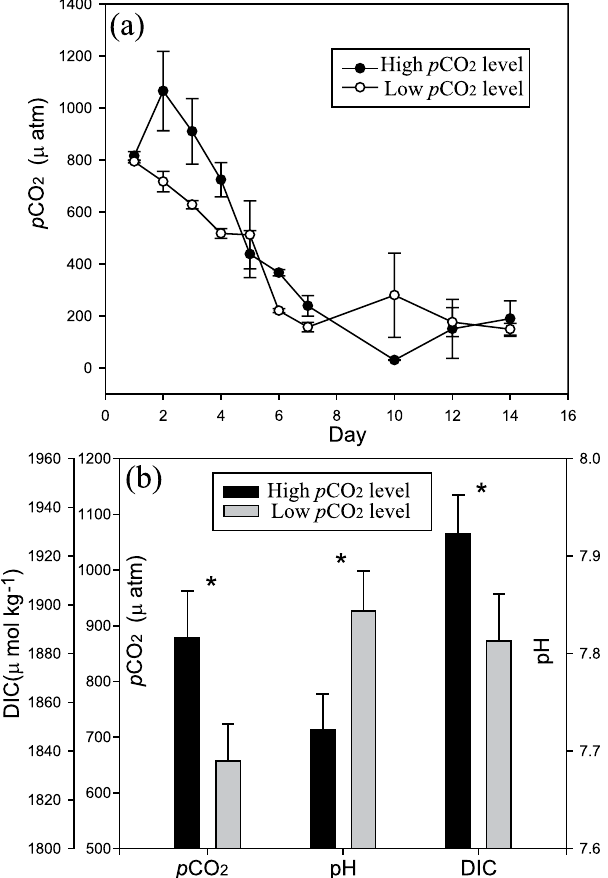
Figure 2. Temporal variations of the CO 2 partial pressure in the seawater ( p CO 2 , μ atm, panel a) in 6 enclosures perturbed by bubbling with ambient air (400 ppmv CO 2 , Low CO 2 level) or an air/CO 2 mixture at a concentration of 1000 ppmv CO 2 (High CO 2 level) over a two week incubation, and comparisons on p CO 2 , pH and dissolved inorganic carbon (DIC) in the first 4 days ( b ). Symbols are the means and error bars are the standard errors of three replicate enclosures. Asterisk ( * ) indicate there are significantly differences between enclosures (p <